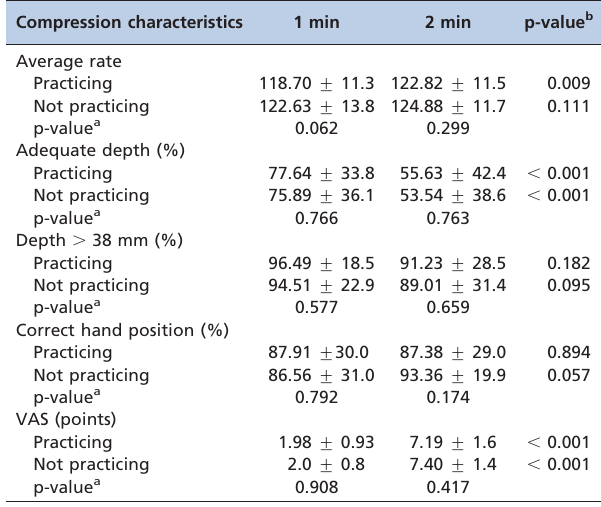
Table 3 - Quality of chest compressions performed for one and two minutes in relation to the practice of regular physical